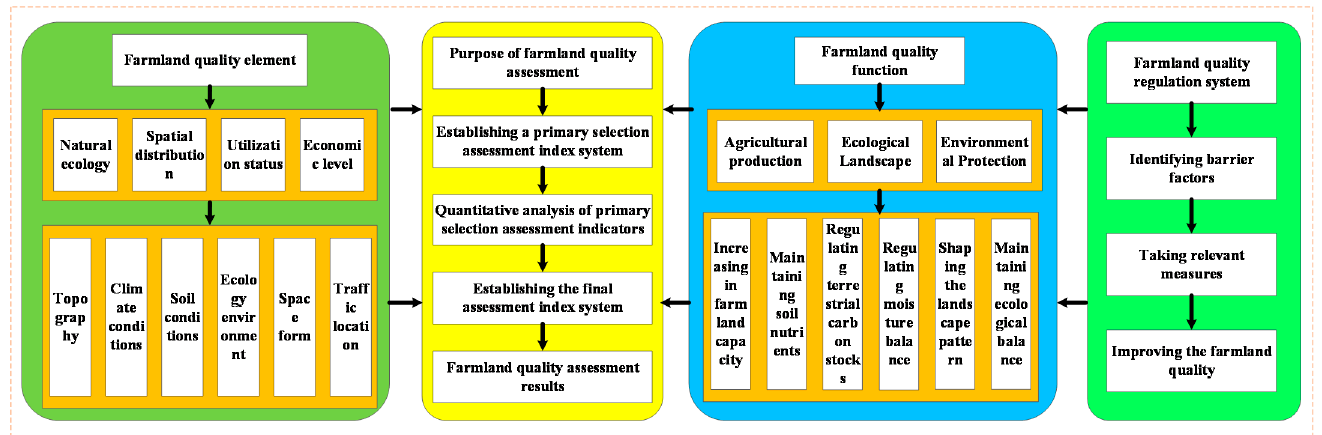
Figure 3. Framework of the farmland quality assessment index system.